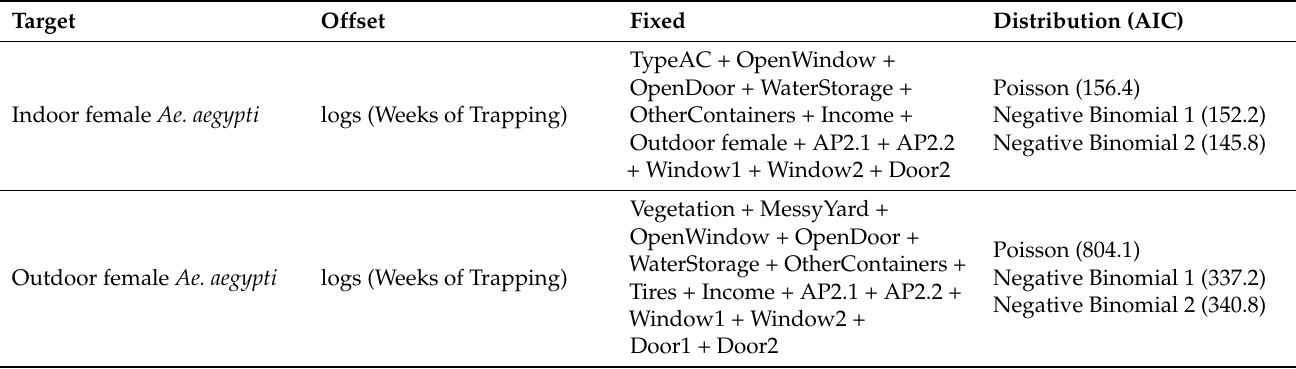
Table 2. Generalized linear model (GLM) fixed effect structure, with Akaike information criterion (AIC) distribution analysis.